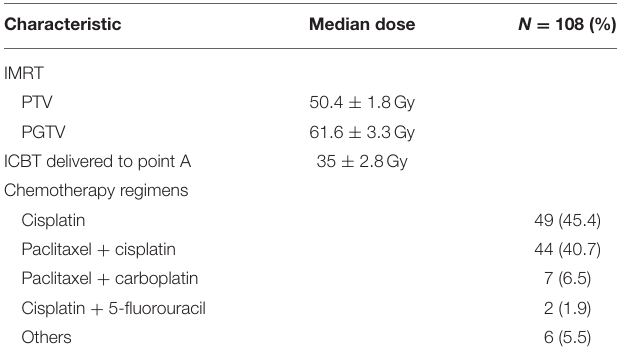
TABLE 2 | Treatment